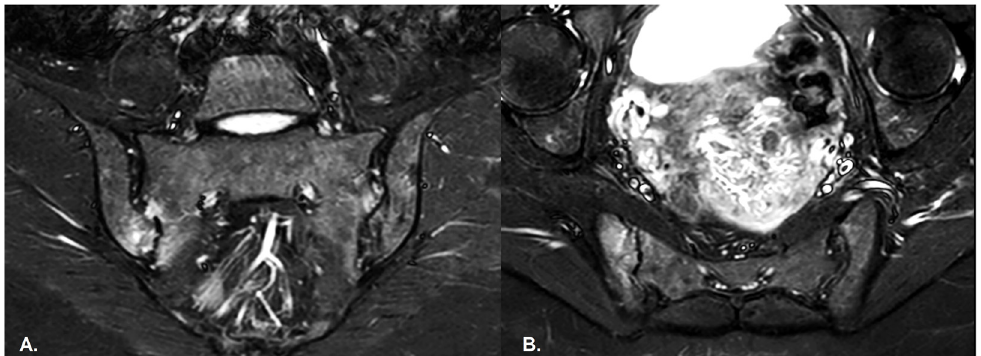
Figure 4. ( A ) Coronal and ( B ) axial STIR sequences show extensive subchondral oedema involving the sacroiliac joints, mainly on the right side and in the inferior regions, consistent with asymmetric active sacroiliitis in a patient with psoriasis.